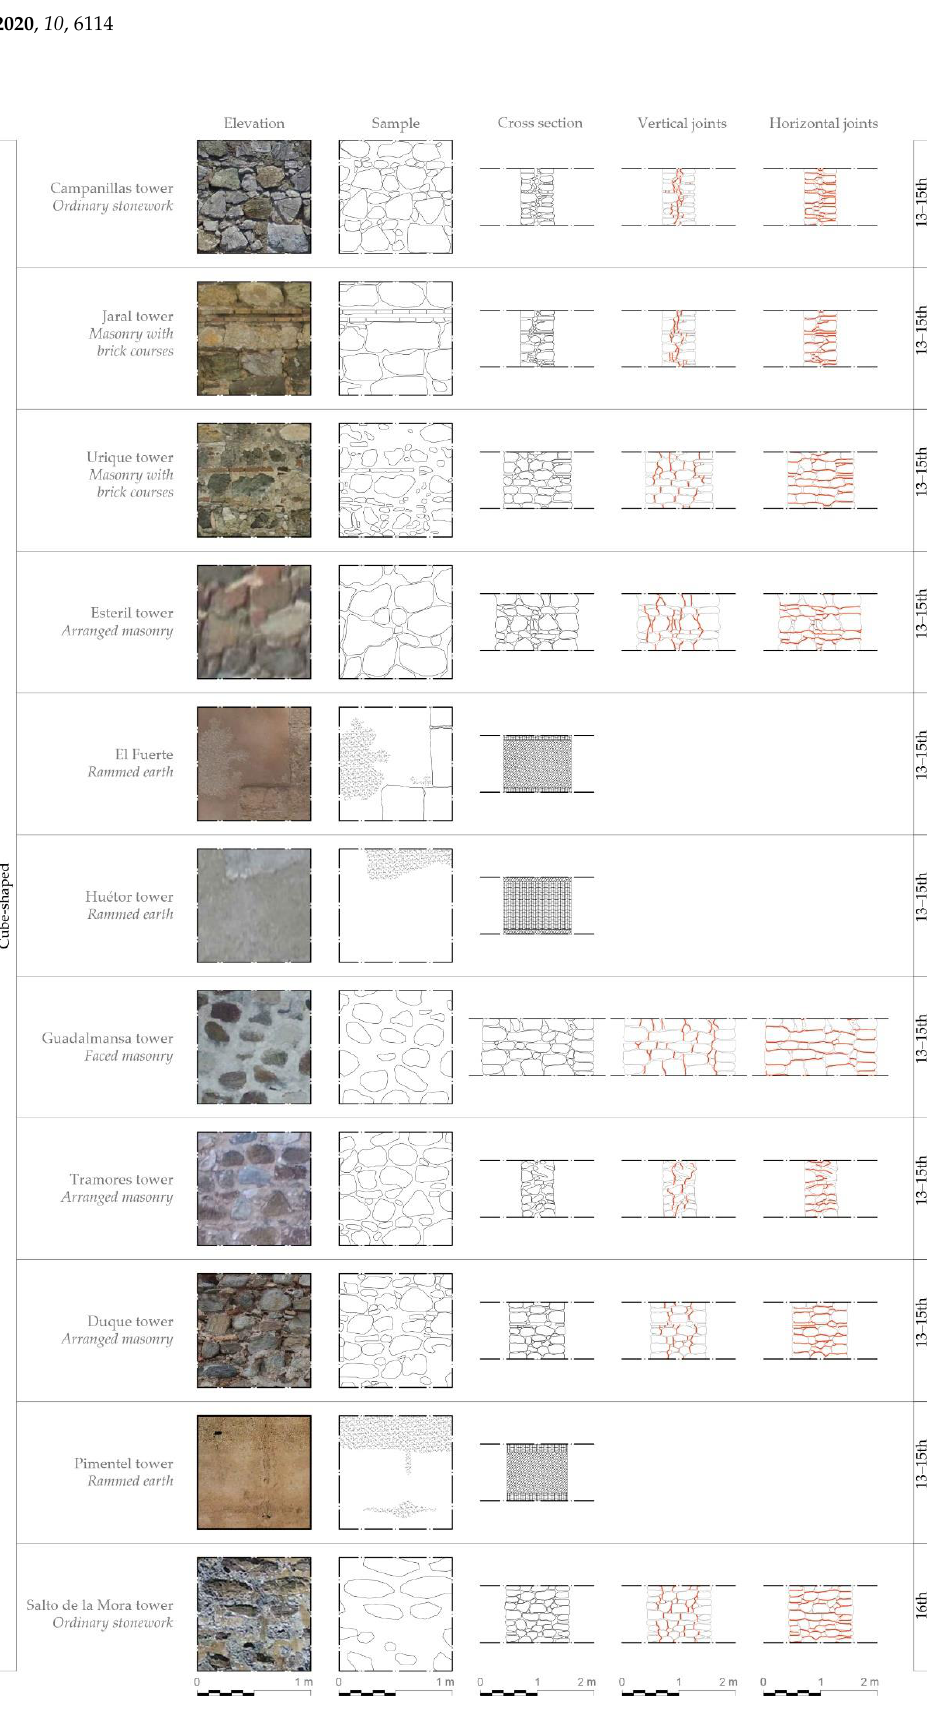
Figure 7. Description of wall construction features in the various towers under study: cube-shaped.